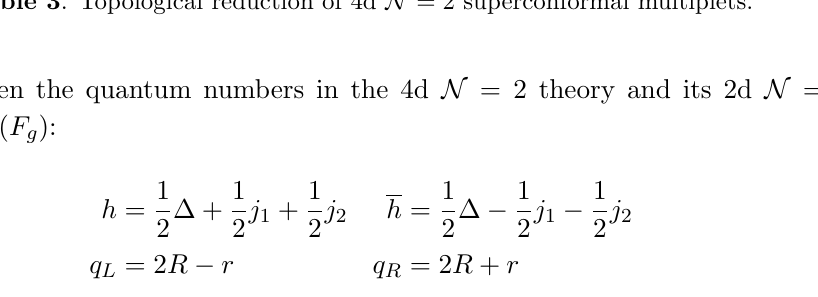
Table 3 . Topological reduction of 4d N = 2 superconformal